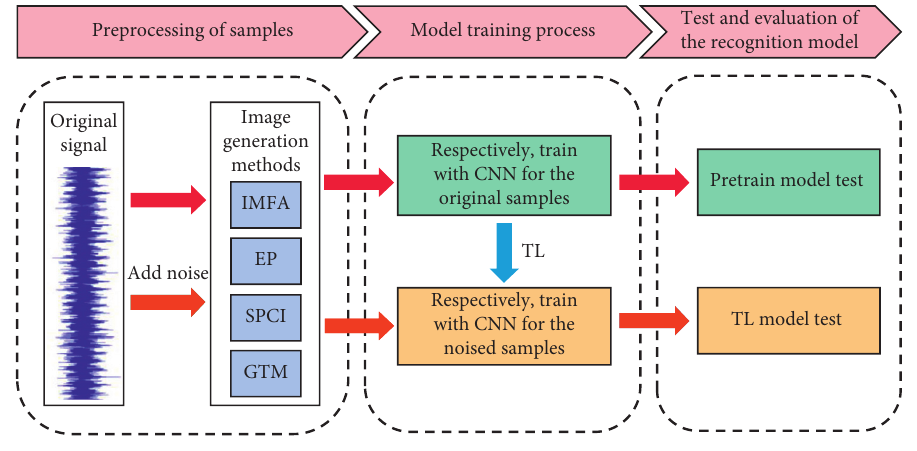
Figure 1: Overall research